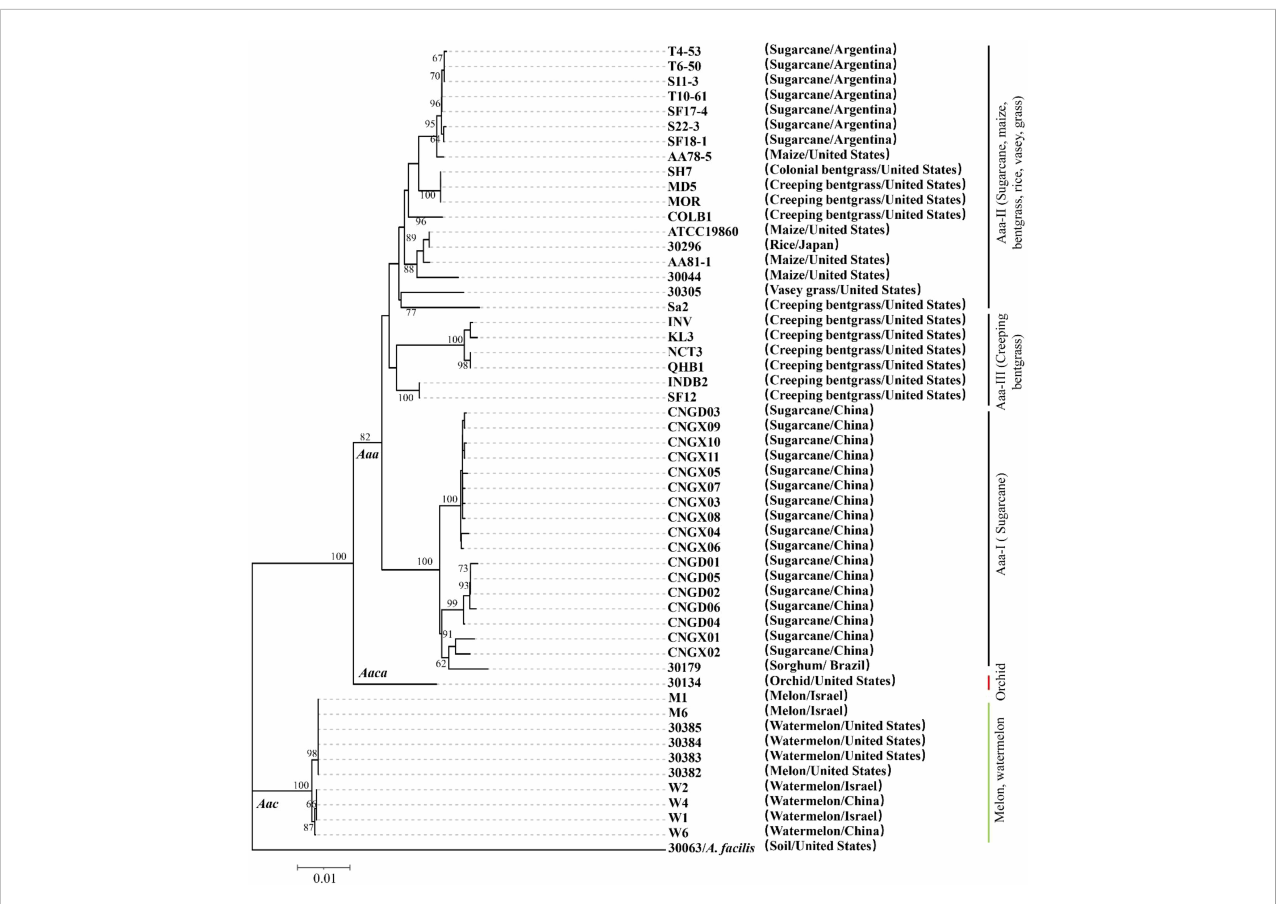
FIGURE 2 Neighbor-joining phylogenetic tree constructed with the concatenated sequence (2,246 nucleotides) of fi ve housekeeping genes from 42 strains of Acidovorax avenae subsp. avenae (17 obtained in this study and 25 retrieved from the NCBI library), 10 strains of A. avenae subsp. citrulli and one strain of A. avenae subsp. cattleyae retrieved from the NCBI library. Strain 30063 of A. facilis was used as an outgroup. The characteristics of all strains are given in Table S1. Bootstrap values were determined for 1,000 replications and only bootstrap values >60% are shown at